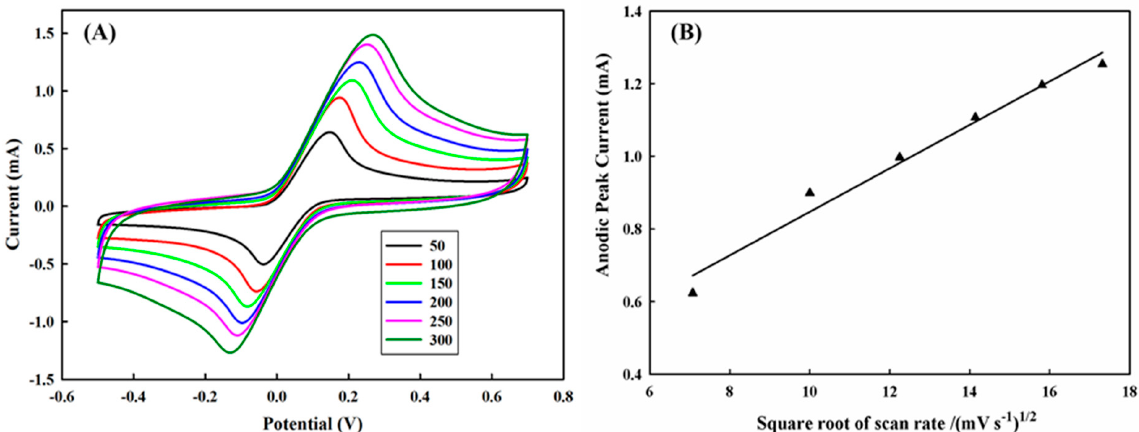
Figure 7. ( A ) The effect of cyclic voltammetry scan rate on the performance of PEDOT/PL electrode for the detection of 6 mM of hydroquinone in 100 mM of PBS buffer. The potential was swept from − 0.5–0.7 V with different scan rate ( B ) The effect of the square root of scan rate on the anodic peak current.